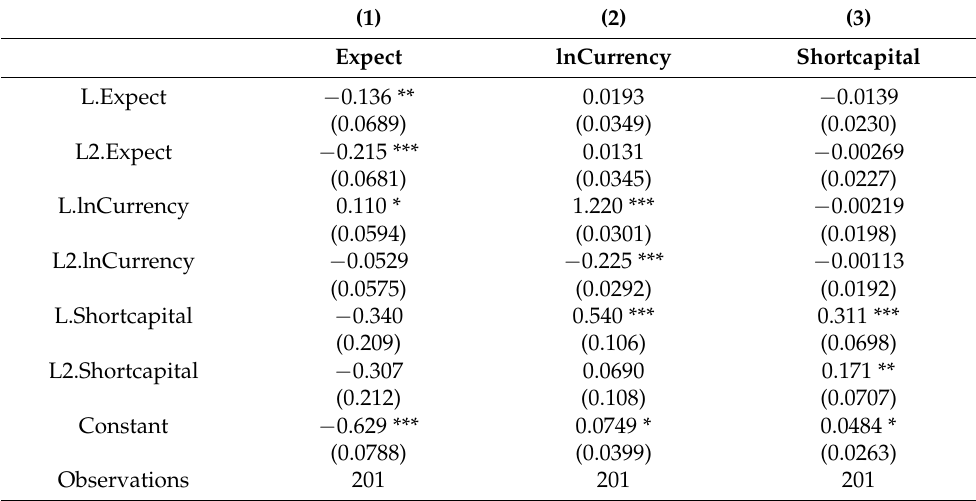
Figure 6. Impulse Response of lnCurrency to Expect and Shortcapital to lnCurrency.